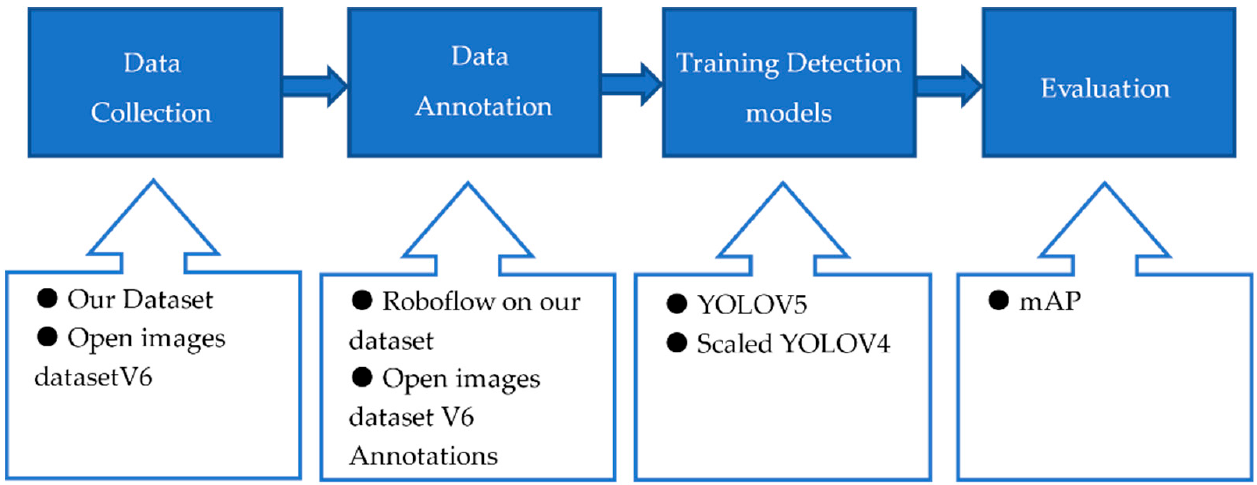
Figure 2. Steps that have been used to assert a high-performance detection model. Each phase in- cluded all options that we used for the comparison in order to get the best detection results.